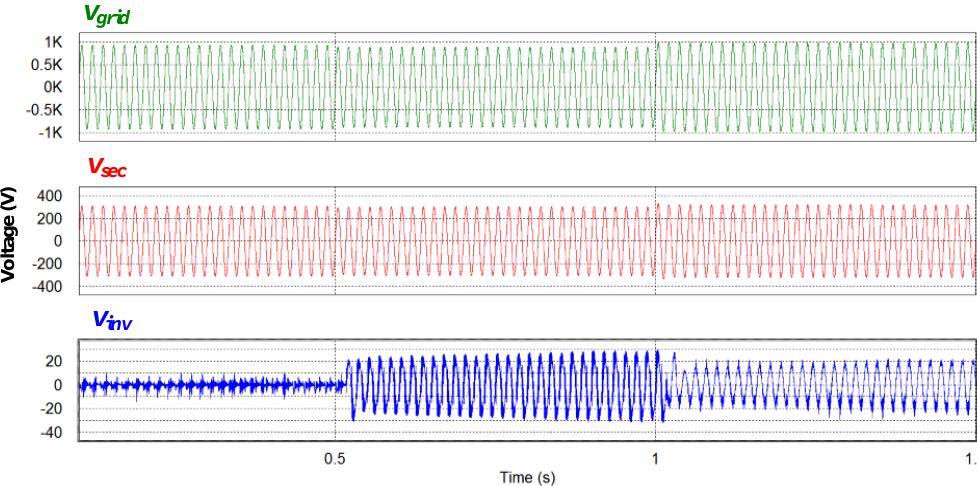
Figure 11. Simulation results of constant voltage control of secondary side.